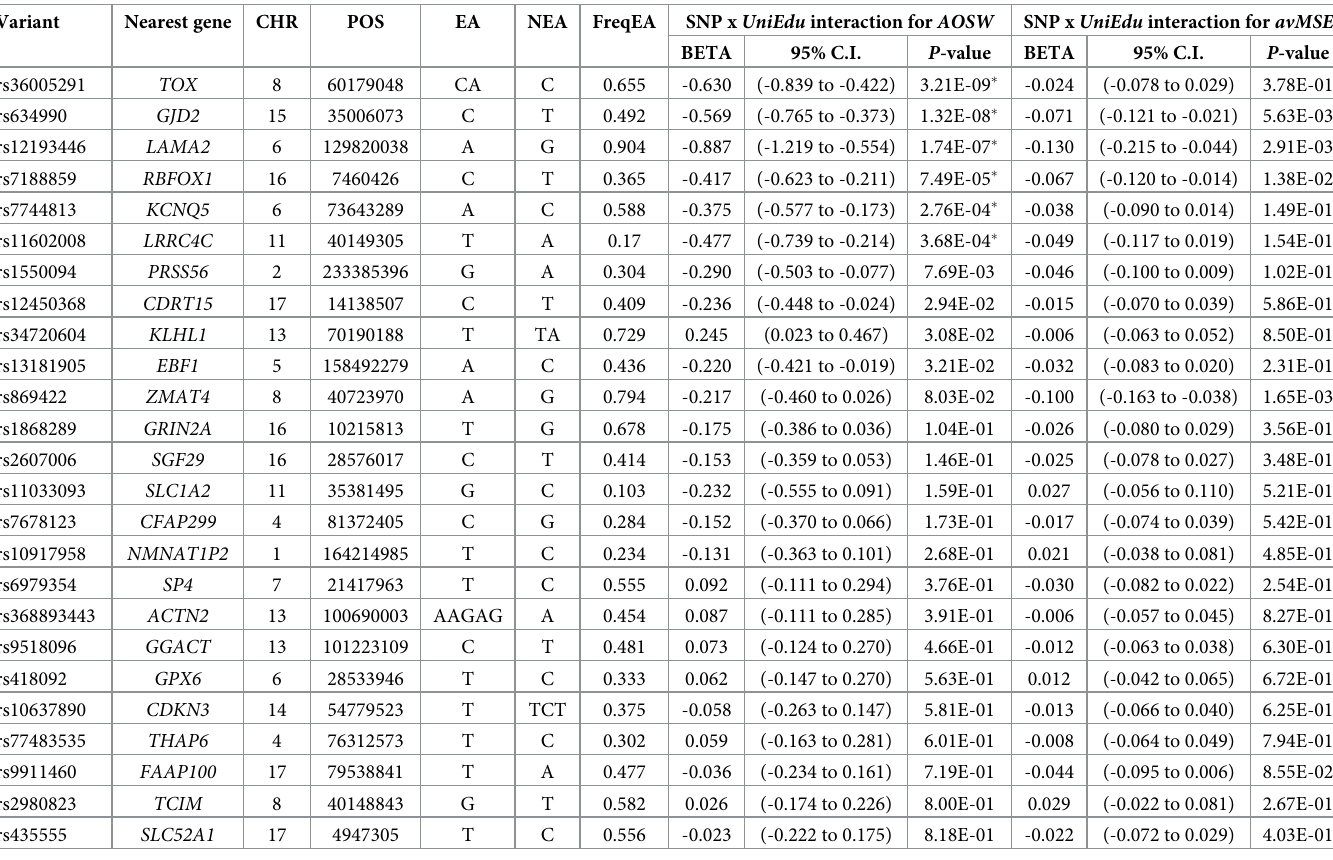
Table 3. Genotype-by- UniEdu (GxE) interaction tests for AOSW in the Stage-II sample and for avMSE in the Stage-I sample. Results shown for the 25 variants with evidence of variance heterogeneity for avMSE in the Stage-I sample. Variants are ranked by p-value for the GxE interaction test in the Stage-II sample. The effect allele is the allele associated with a more myopic refractive error in a linear regression test for the marginal effect of the variant. Variant Nearest gene